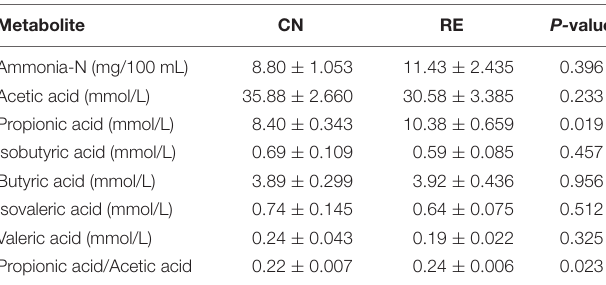
TABLE 6 | Effects of herbal tea residue feed on the rumen fermentation parameters of finishing steers.